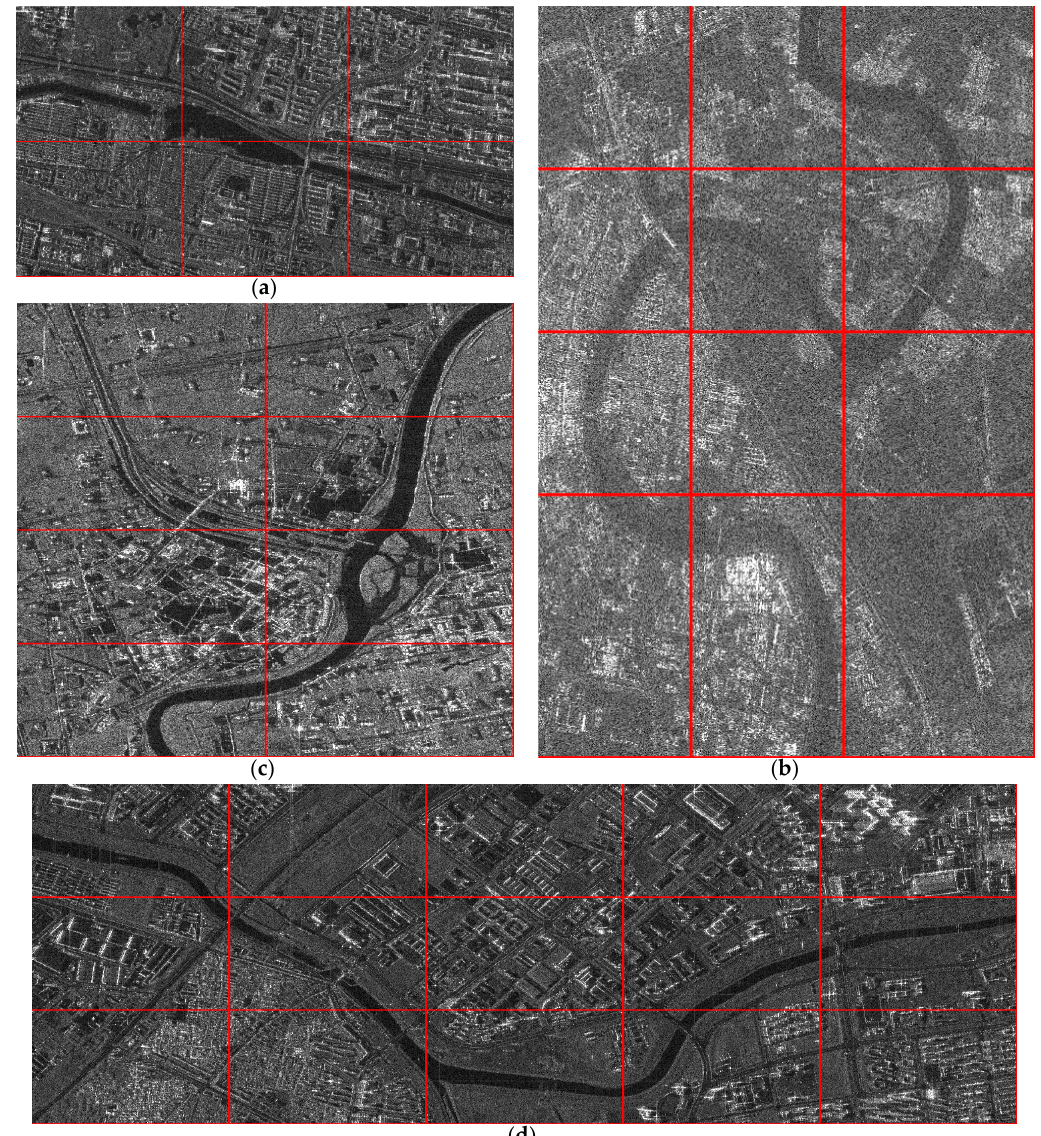
Figure 16. SAR test images covering urban riverways. ( a ) 1100 × 1800; ( b ) 3000 × 1950; ( c ) 1400 × 1000, and ( d ) 1550 × 2950 pixels.